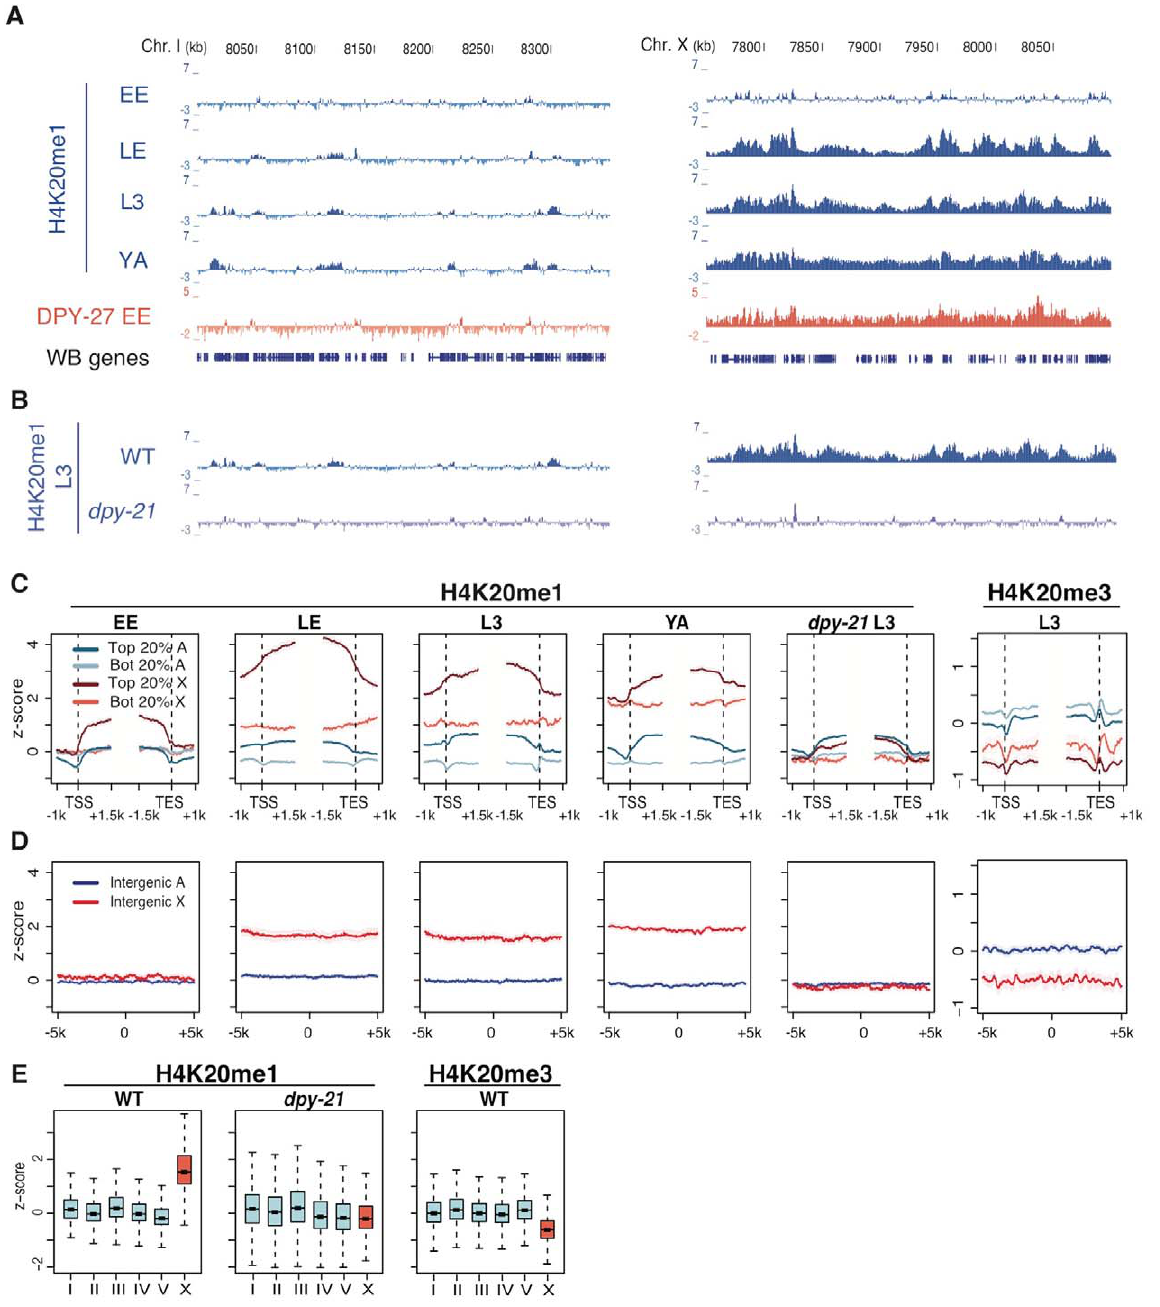
Figure 1. H4K20me1 becomes enriched on the X chromosome in wild type but not in a mutant defective in dosage compensation. (A) Genome browser tracks of indicated ChIP signals across representative regions of chromosome I and chromosome X in wild-type early embryos (EE), late embryos (LE), L3 larvae (L3), and fem-2 female young adults (YA). For each track, the average of two independent biological replicates is shown as z-scores (standardized log 2 ratios of ChIP/Input signals). High H4K20me1 enrichment on X begins in late embryos. A track of DPY-27 (a DCC component) is shown for reference. (B) Enrichment of H4K20me1 on the X is lost in dpy-21 mutants. (C) Plots of H4K20me1 and H4K20me3 signal across the TSS (transcript start site) and TES (transcript end site) of genes on X (red) and autosomes (blue). Genes in the top 20% of expression (dark shades) and bottom 20% (light shades) are plotted separately. (D) Plots of H4K20me1 and H4K20me3 signal centered at intergenic regions at least 5 kb from any annotated feature. (E) Box plots of overall H4K20me1 and H4K20me3 signals on each chromosome. Each box shows the median and extends from the 25 th to the 75 th percentile of the z-scores in the set; whiskers extending from the box indicate the 2.5 th and 97.5 th percentiles.